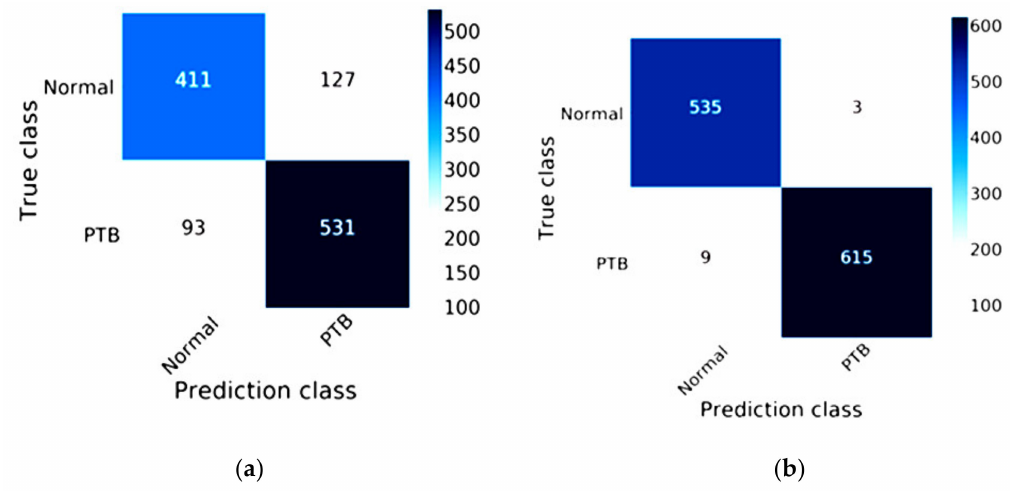
Figure 11. Confusion matrix of DenseNet-121: ( a ) the traditional method results of DenseNet-121; ( b ) the results of DenseNet-121combined with Mish and Nadam.